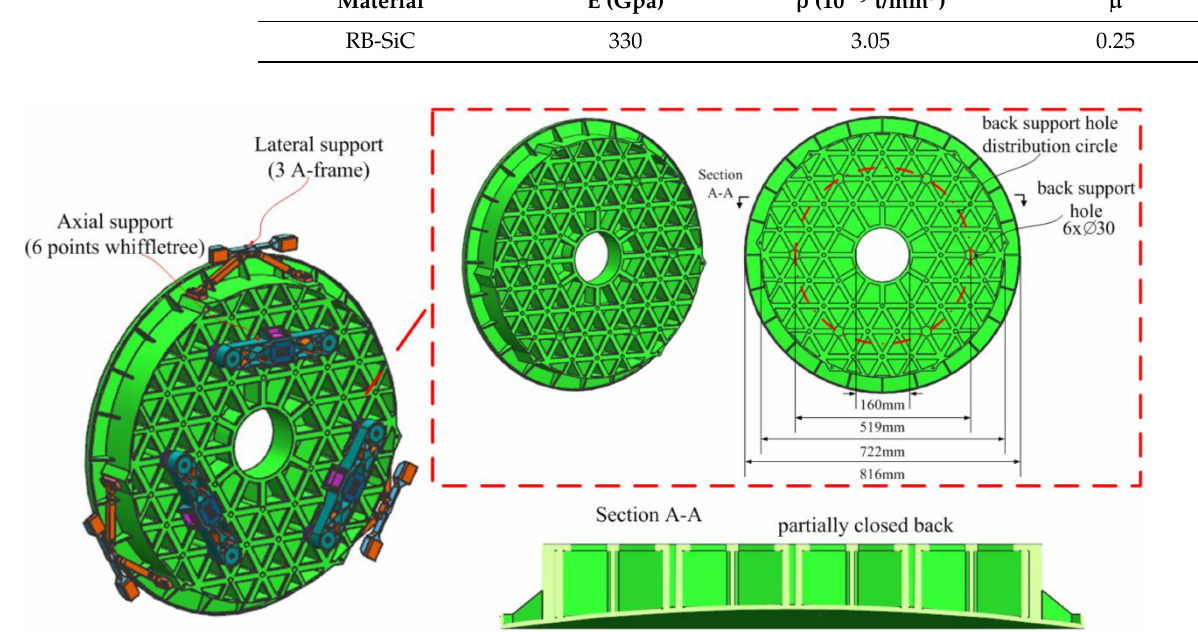
Figure 2. Primary mirror assembly showing the lateral support, axial support, mirror body, the back support holes, and basic